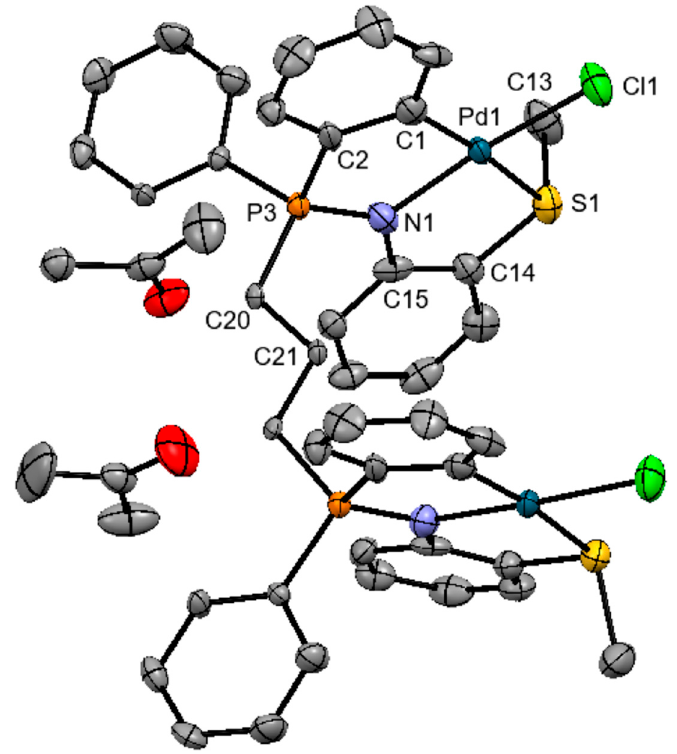
Figure 1. ORTEP drawing of complex 3c with thermal ellipsoid plot shown at 50% probability level. Hydrogen atoms have been omitted for clarity. Selected bond distances (Å) and angles (°) for 3c : Pd(1)-C(1) 1.962(8), Pd(1)-N(1) 2.039(6), Pd(1)-Cl(1) 2.316(2), Pd(1)-S(1) 2.358(2), P(3)-N(1) 1.616(7),